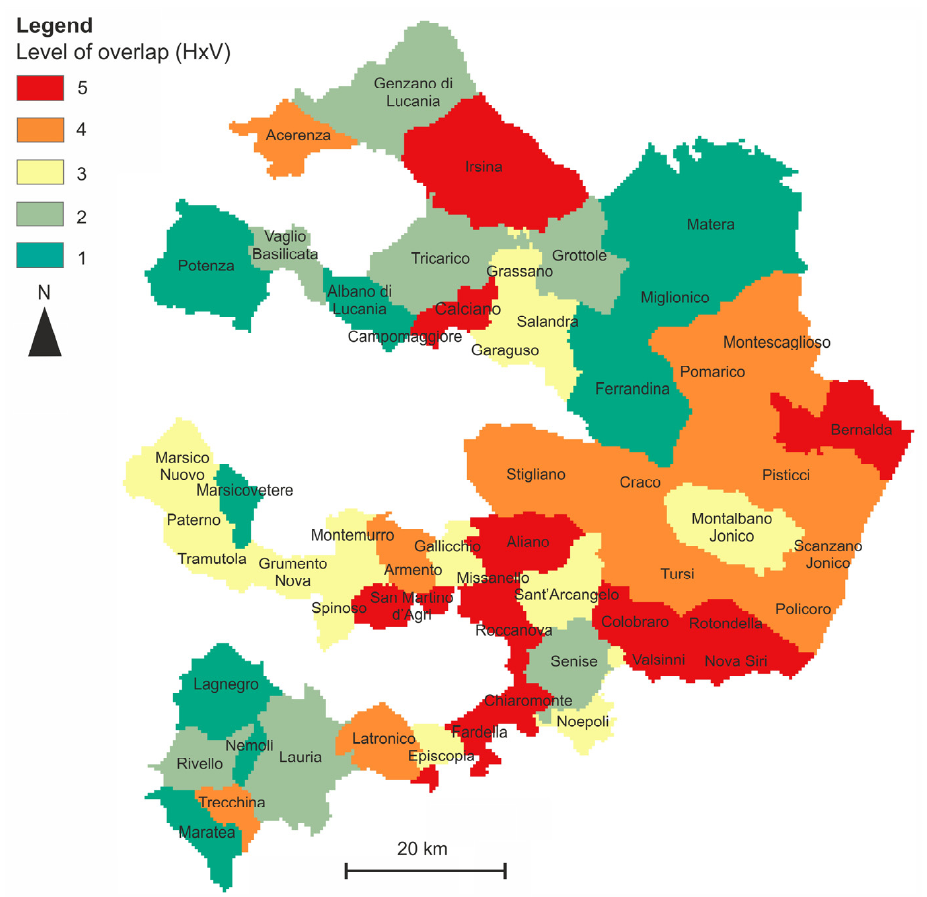
Figure 8. Final raster derived from the overlap between flood hazard and social vulnerability index. Class 1 = very low; class 2 = low; class 3 = medium; class 4 = high; class 5 = very high.